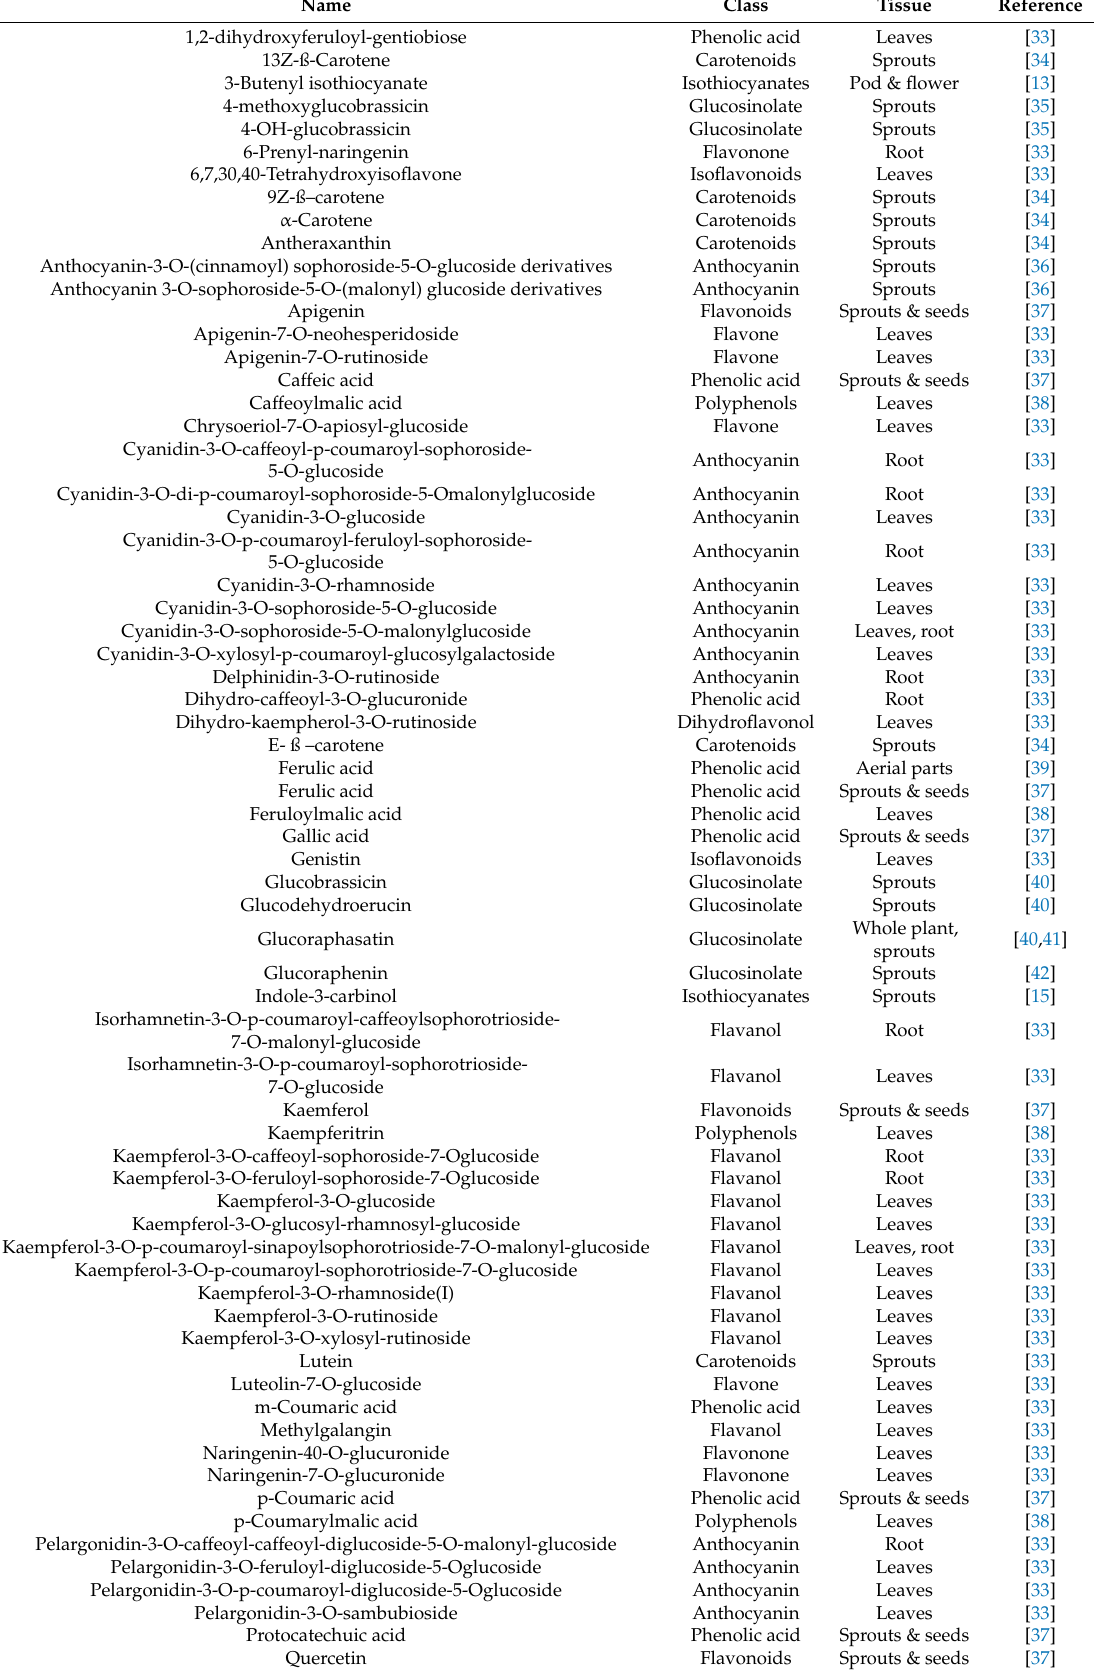
Table 1. List of secondary metabolites with antioxidant properties identified in different parts of